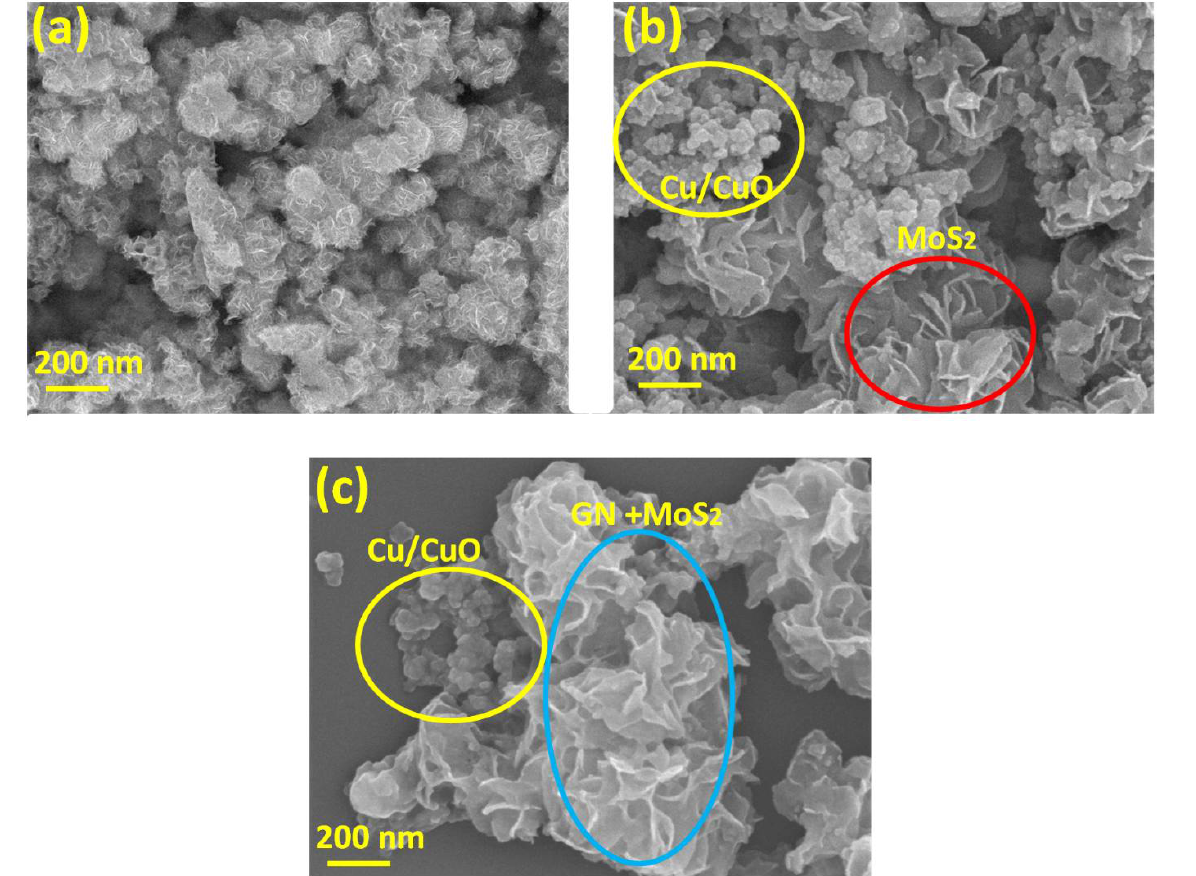
Figure 6. Surface morphology of ( a ) MoS 2 , ( b ) MoS 2 -Cu/CuO and ( c ) MoS 2 -Cu/CuO@GN.